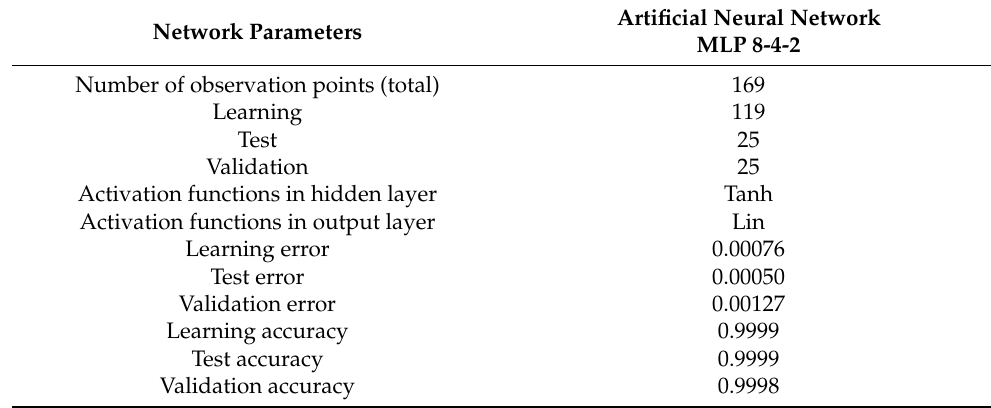
Table 1. Basic information on the architecture and error values for the learning, test and validation process of the MLP neural network selected as a model estimating ethanol and acetone concentrations in liquid mixtures based on the response of a single thermally modulated metal-oxide semiconductor gas sensor.